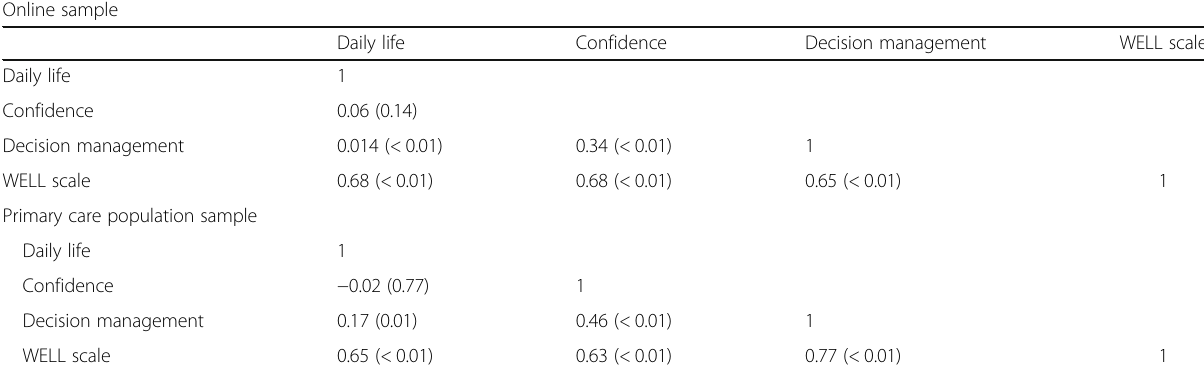
Table 3 Correlation matrix for online and primary care clinic populations Online sample